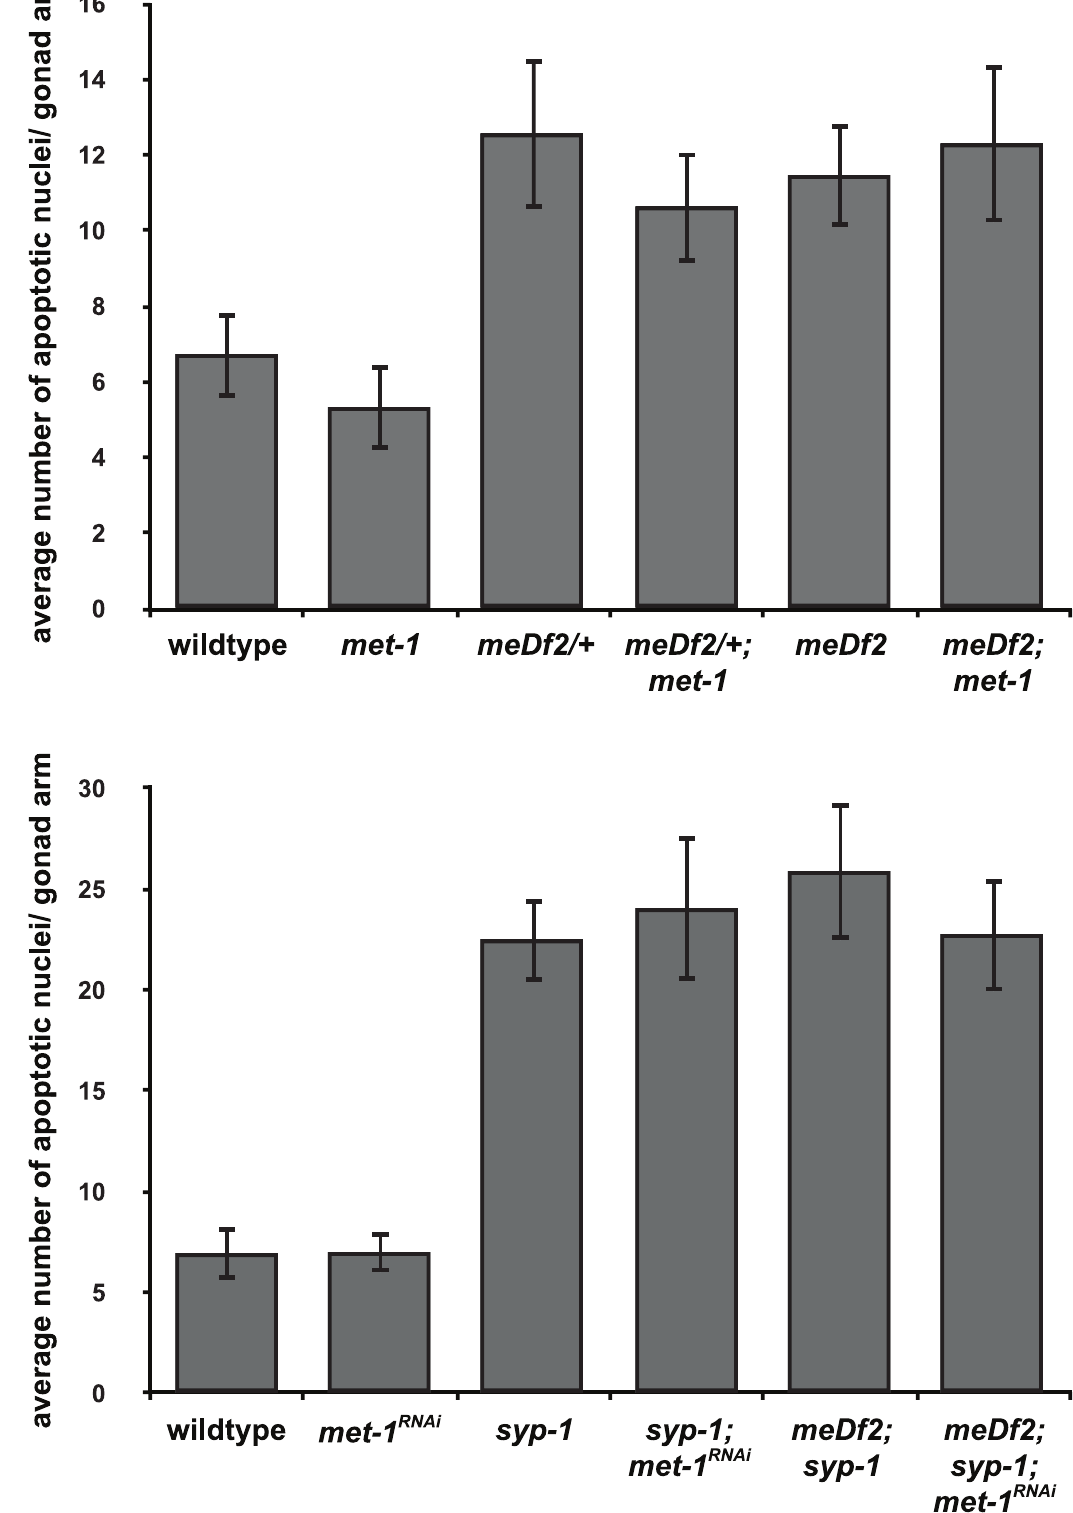
Figure 5. met-1 is not required for the synapsis checkpoint when only X chromosomes are unsynapsed. A. Mutation of met-1 does not reduce apoptosis in meDf2/ + or meDf2 homozygotes. B. Inactivation of met-1 by RNAi in meDf2; syp-1 double mutants does not reduce apoptosis. Error bars indicate 2XSEM. doi:10.1371/journal.pgen.1003089.g005 PLOS Genetics |